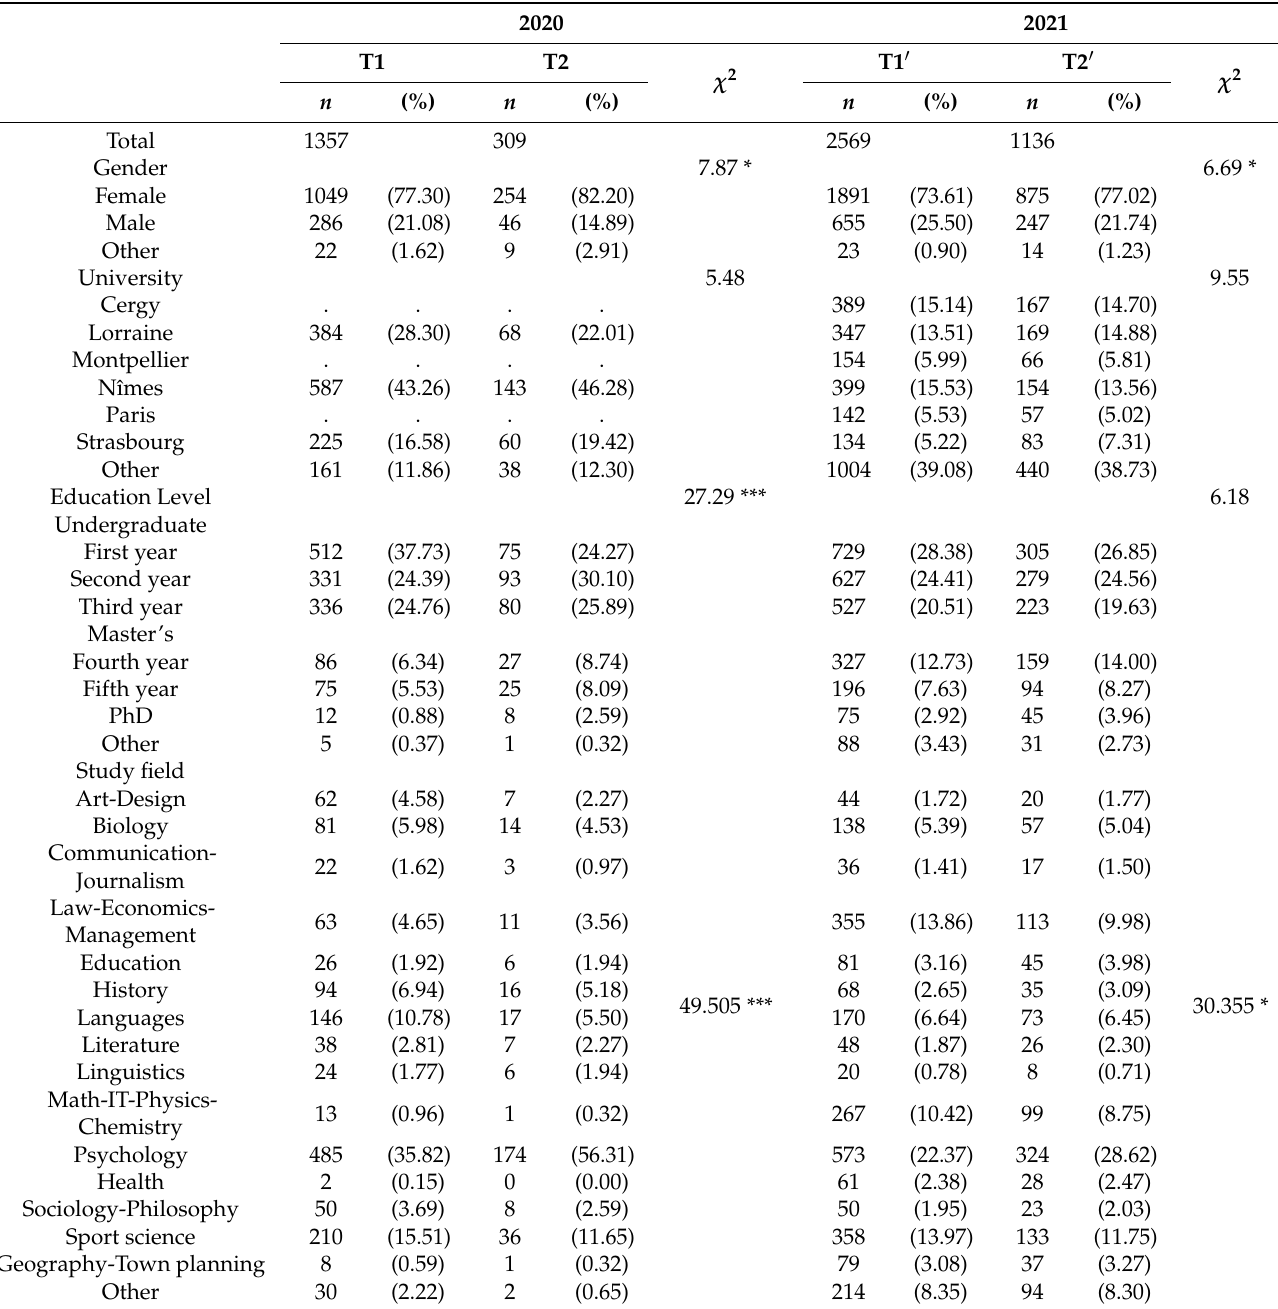
Table 1. Characteristics of survey respondents at the four time